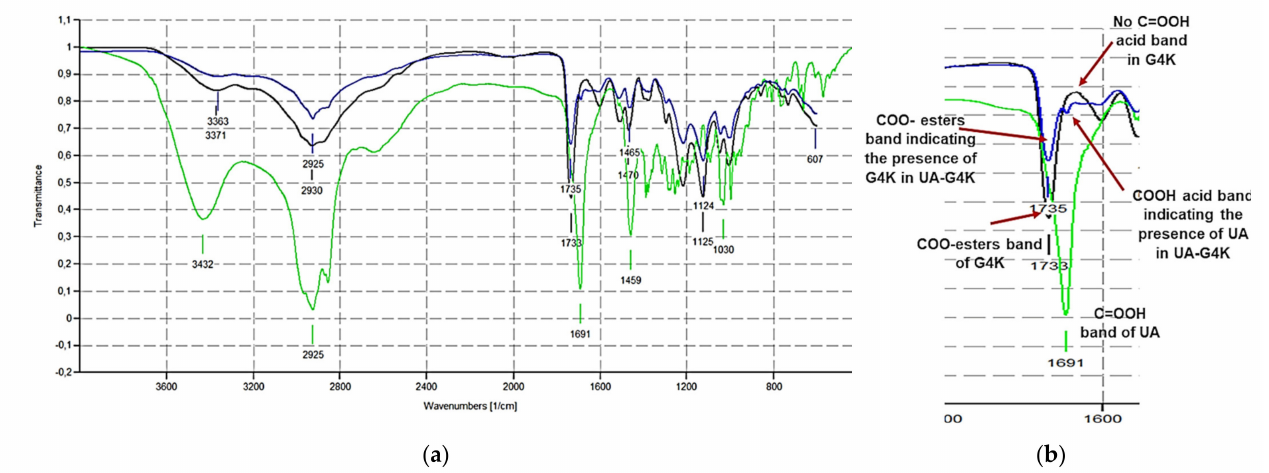
Figure 3. Fourier transform infrared spectroscopy (FTIR) spectra of G4K (black line), UA (green line), and of UA-G4K (blue line) ( a ); magnification of a significant spectral region ( b